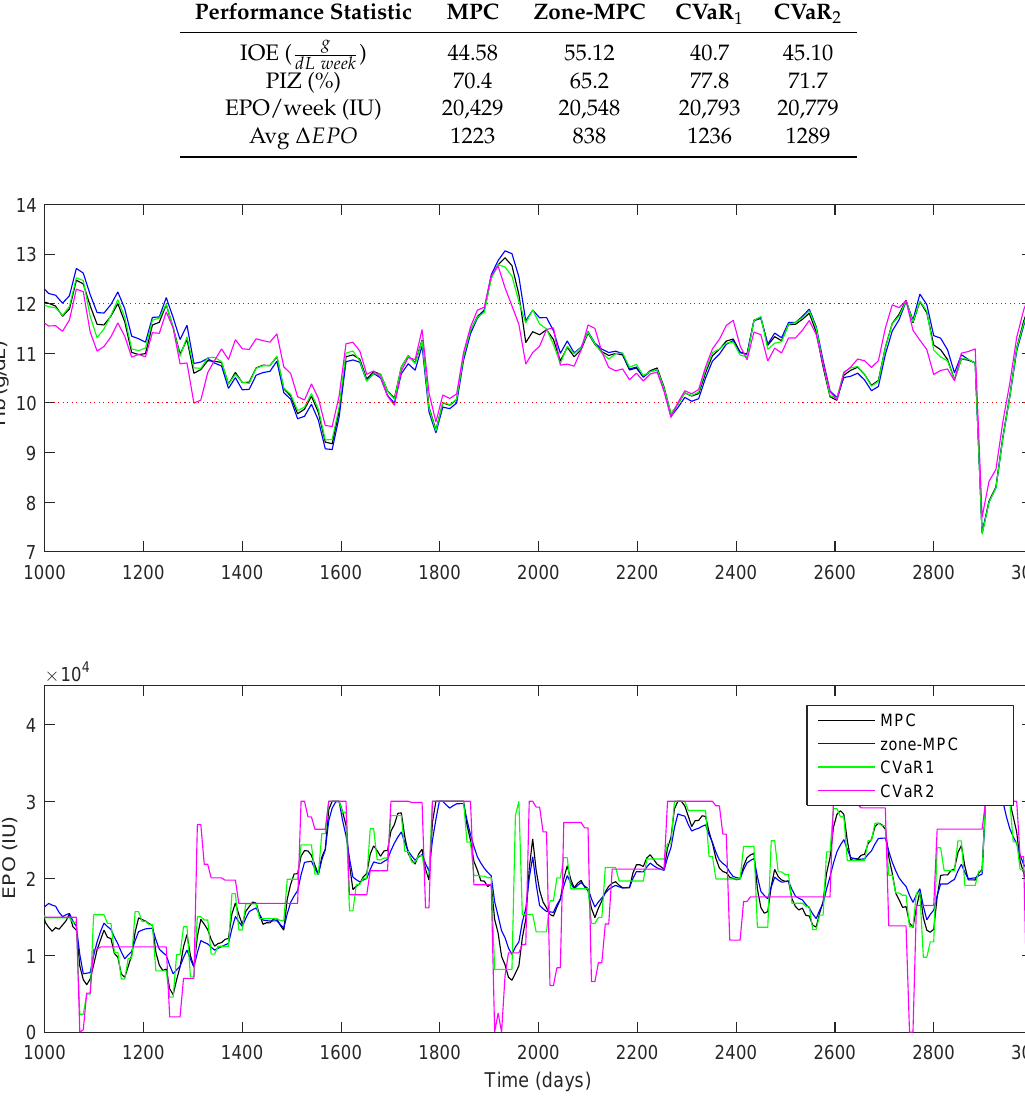
Figure 12. Results under uniform process